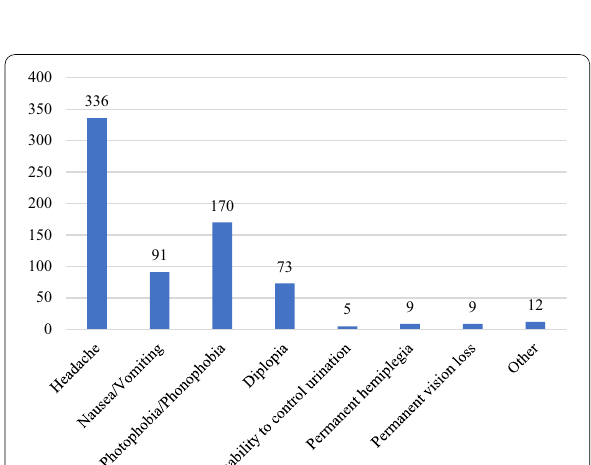
Fig. 2 Symptoms of migraine as perceived by the population of the study